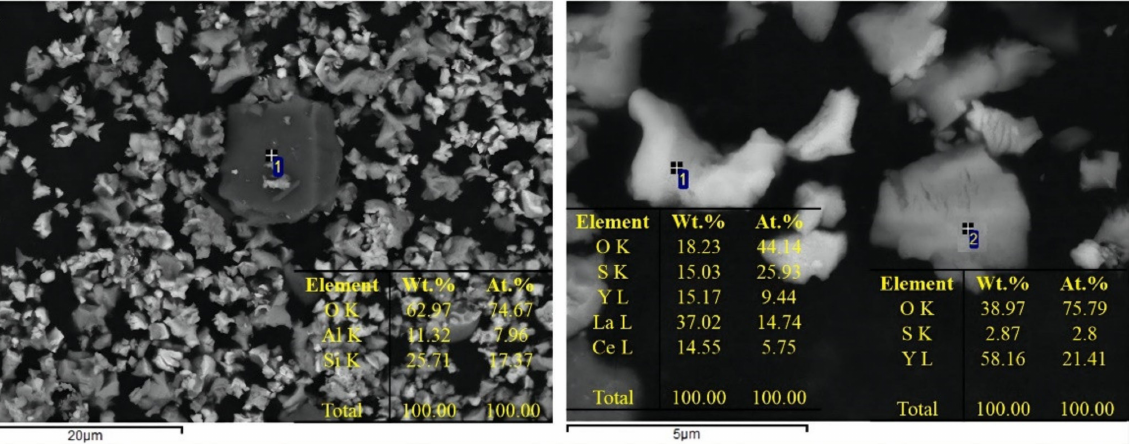
Figure 10. Analysis of morphology and EDS of electrolytic inclusions in non-aqueous solution of 200RE